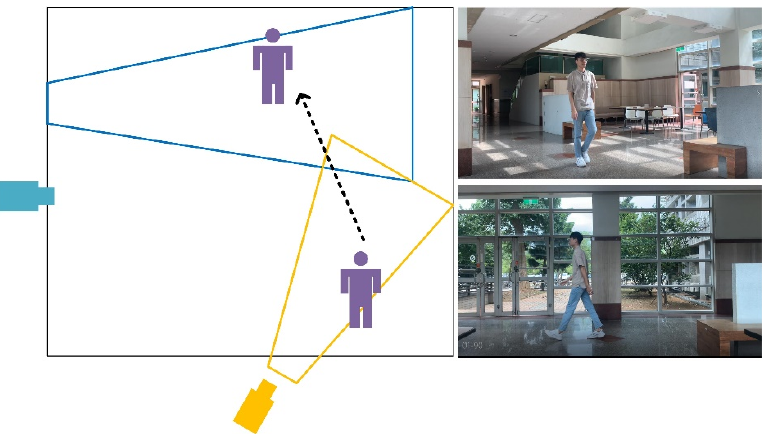
Figure 1. Multi-camera re-identification (Re-ID) scenario.